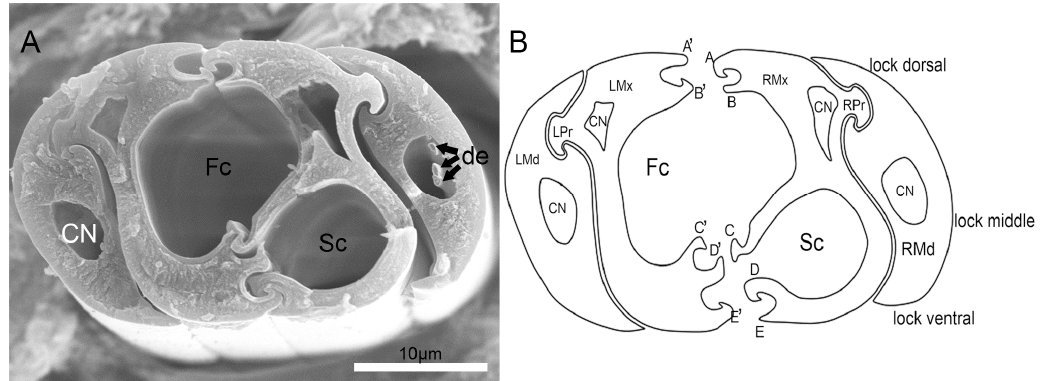
Figure 9. Cross-section of stylet of C.nigrescens . ( A ) Cross-section of stylet fascicle; ( B ) diagram of cross-section of stylet fascicle. A, hooked upper right process of the dorsal lock; A’, straight upper left process of the dorsal lock; B, straight lower right process of the dorsal lock; B’, hooked lower left process of the dorsal lock; C, T-shaped right process of the middle lock; C’, hooked upper left process of the middle lock; CN, nerve canal; D, hooked upper right process of the ventral lock; D’, hooked lower right process of the middle lock; de, dendrite; E, straight lower right process of the ventral lock; E’, hooked lower left process of the ventral lock; Fc, food canal; LMd, left mandibular stylet; LMx, left maxillary stylet; LPr, left process of the maxilla; RMd, right mandibular stylet; RMx, right maxillary stylet; RPr, right process of the maxilla; and Sc, salivary canal.